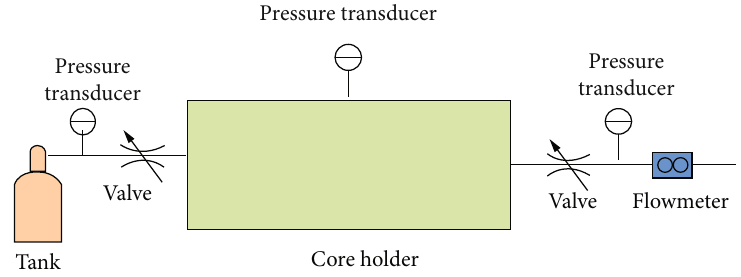
Figure 3: Sketch map of shale gas fl